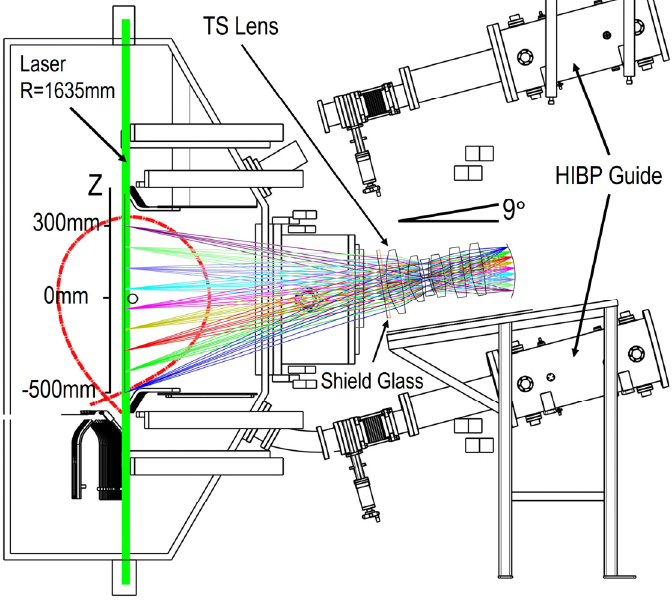
Figure 1. View of the new TS collection’s lens layout and nearby HIBP system. Here, the red curve is the plasma separatrix.